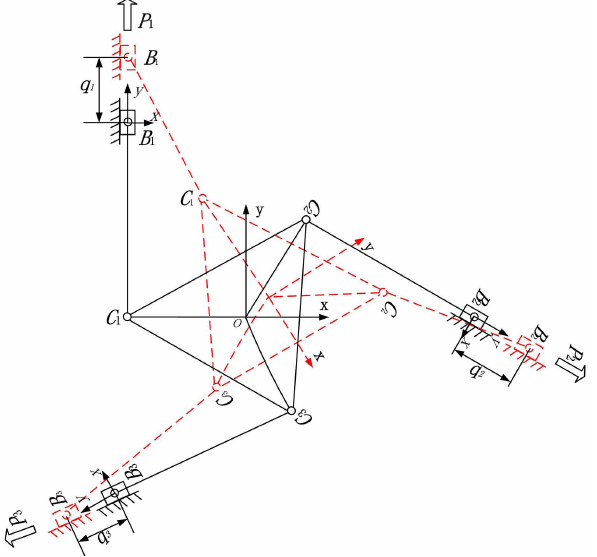
Figure 11. The kinematic schematic of 3-PRR planar